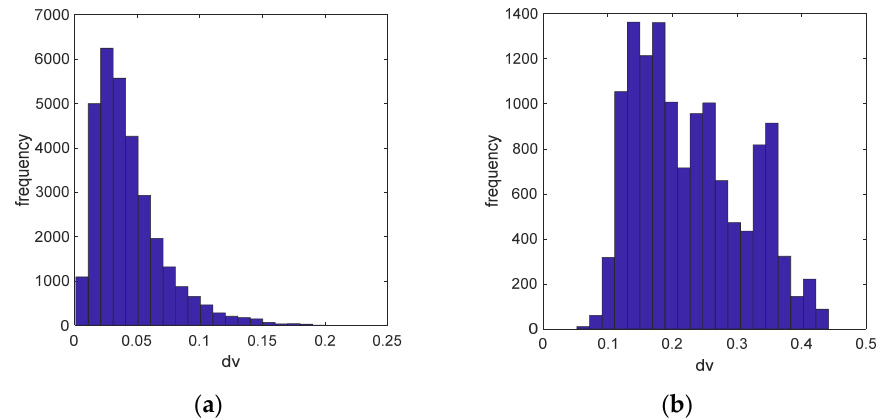
Figure 12. Similar areas merge results with different d s : ( a ) Before similar areas merge; ( b ) Similar areas merge result when d s is set to 30 and 40 ( d s = 30, 40); ( c ) d s = 50; ( d ) d s = 60,70,80,90; ( e ) d s = 100,150; ( f ) d s = 200.